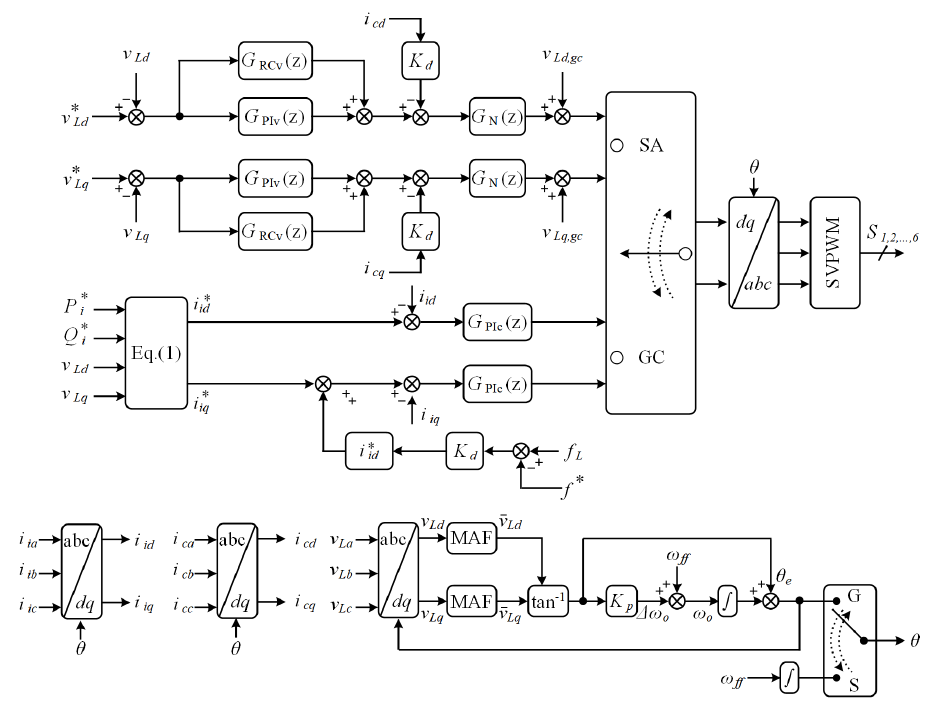
Figure 4. Block diagram of the overall proposed control